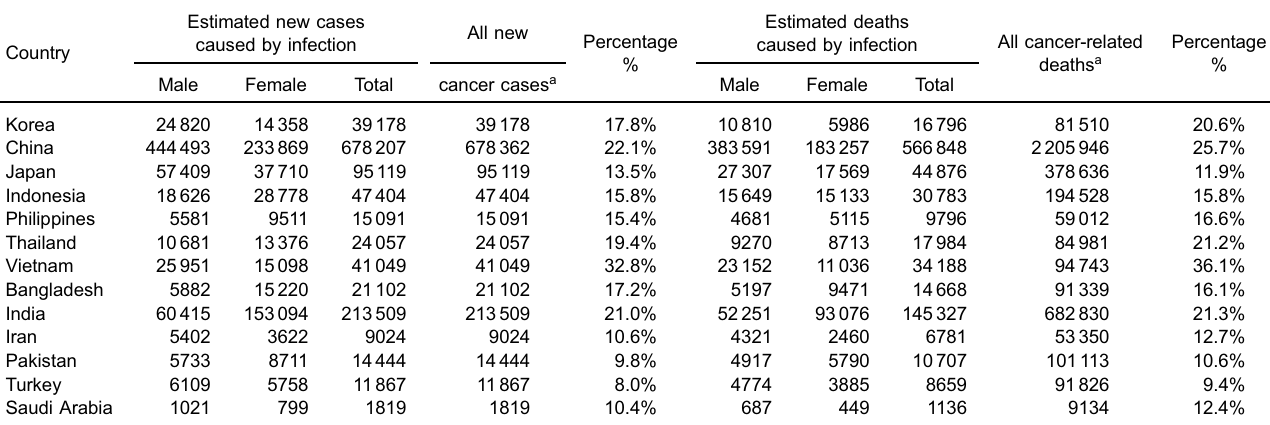
Table 5. Estimated new cancer cases and deaths caused by infection in 2012, by country Estimated new cases caused by Country